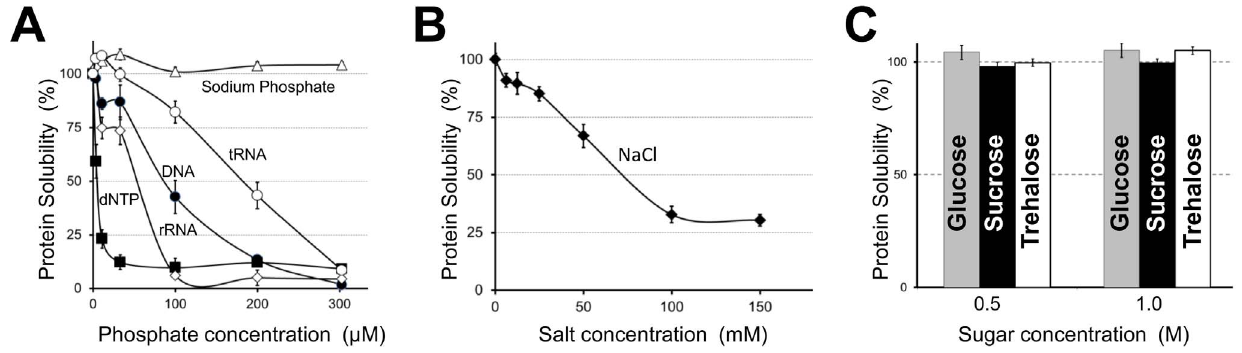
Figure 3. Effect of additives on protein solubility in HeLa cell TRIzol lysates. The solubility of proteins remaining after addition of nucleic acids ( A ), sodium chloride ( B ) or carbohydrates ( C ) was determined.